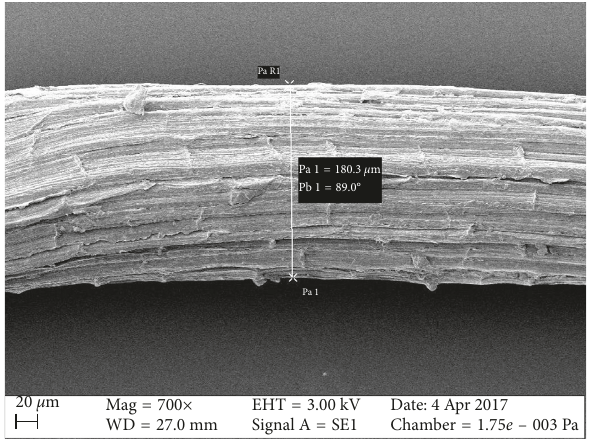
Figure 3: Treated sisal